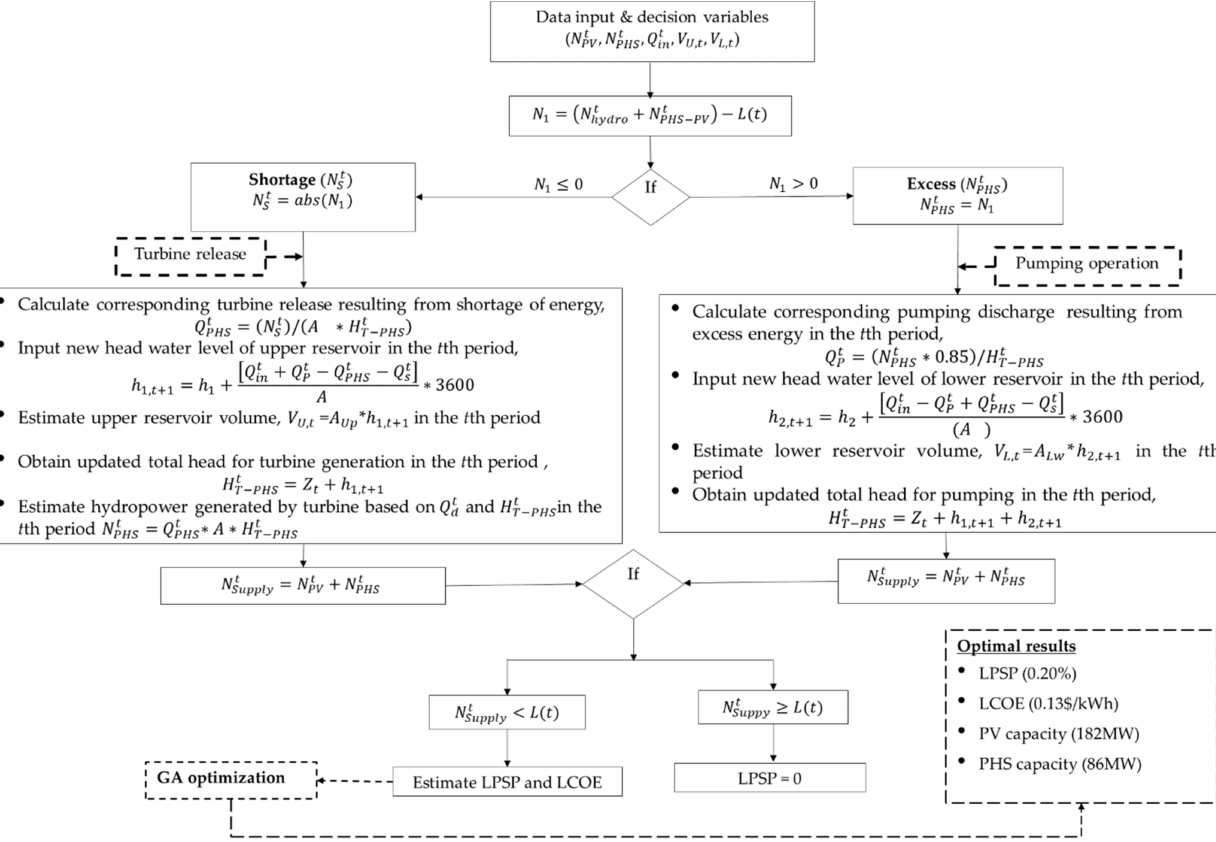
Figure 3. Detailed flow chart of the quasi-steady operation